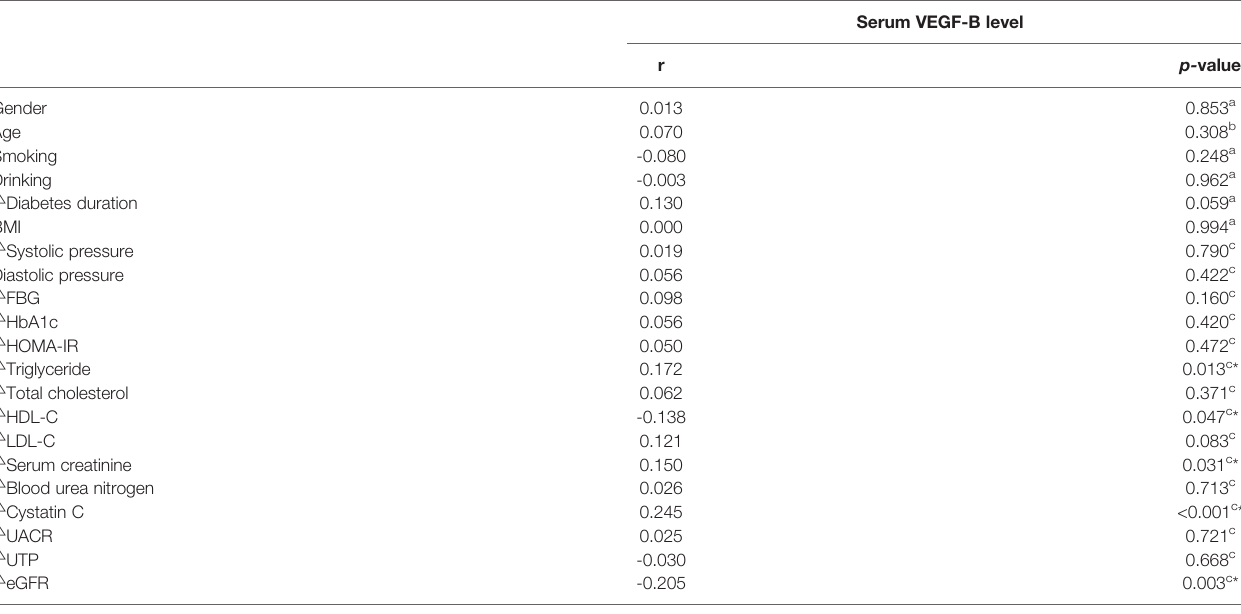
TABLE 3 | The correlation of serum VEGF-B (log-transformed) with clinical indicators in T2DM